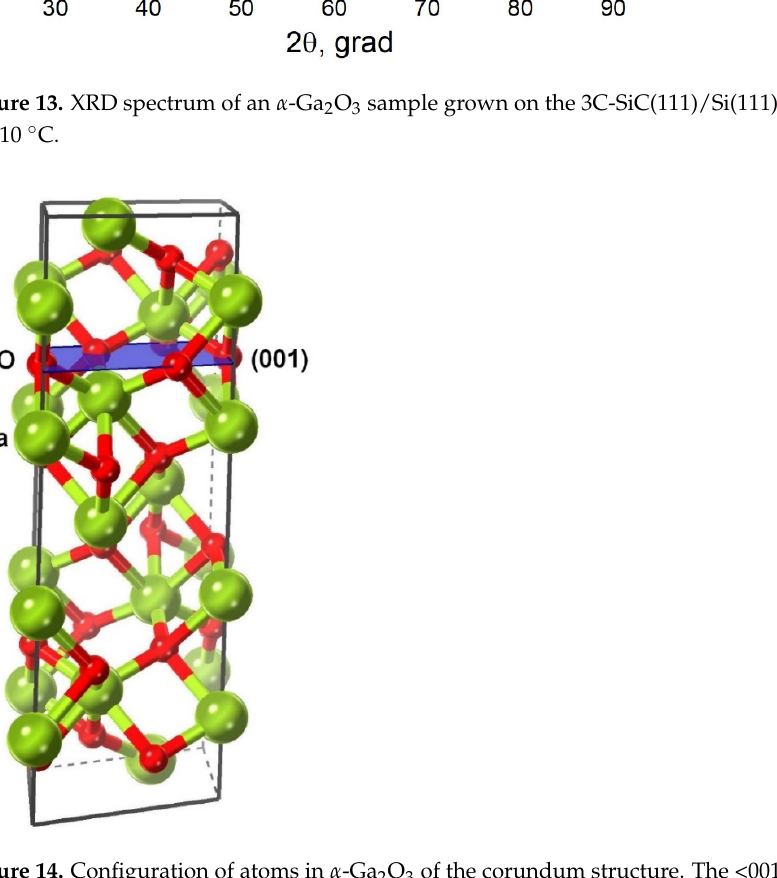
Figure 13. XRD spectrum of an 𝛼 -Ga 2 O 3 sample grown on the 3C-SiC(111)/Si(111) hybrid substrate at 510 °C.